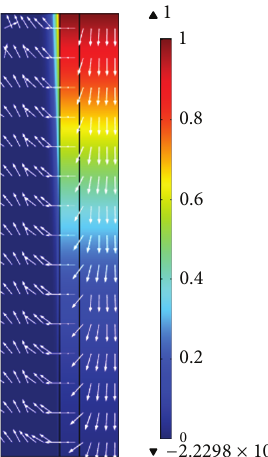
Figure 4: Flux vectors of CO 2 ( 𝐶/𝐶 0 ) in the model. 𝐶 0 = 4 molm −3 ,